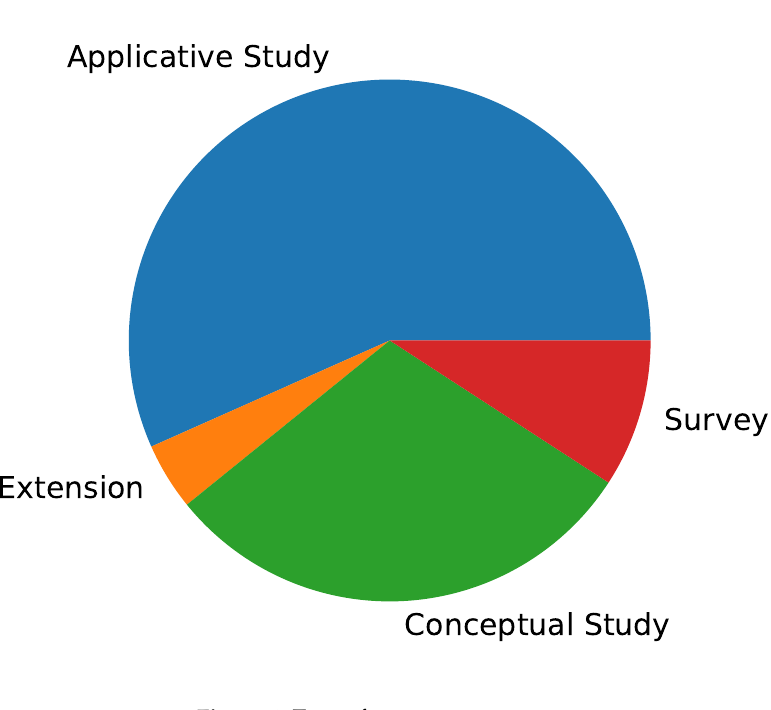
Figure 4. Type of content.